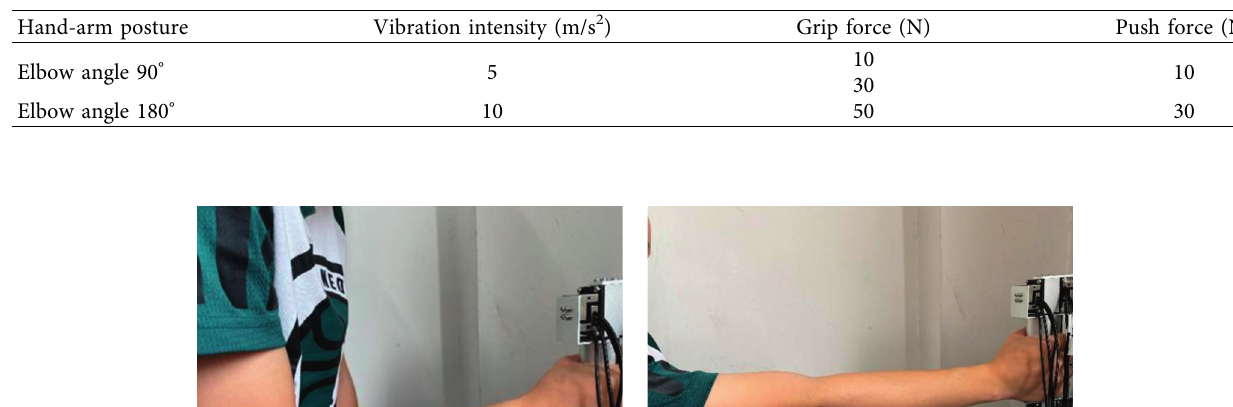
Figure 5: Schematic diagram of the mechanical impedance measurement process of the hand-arm Table 2: Levels of different test factors.